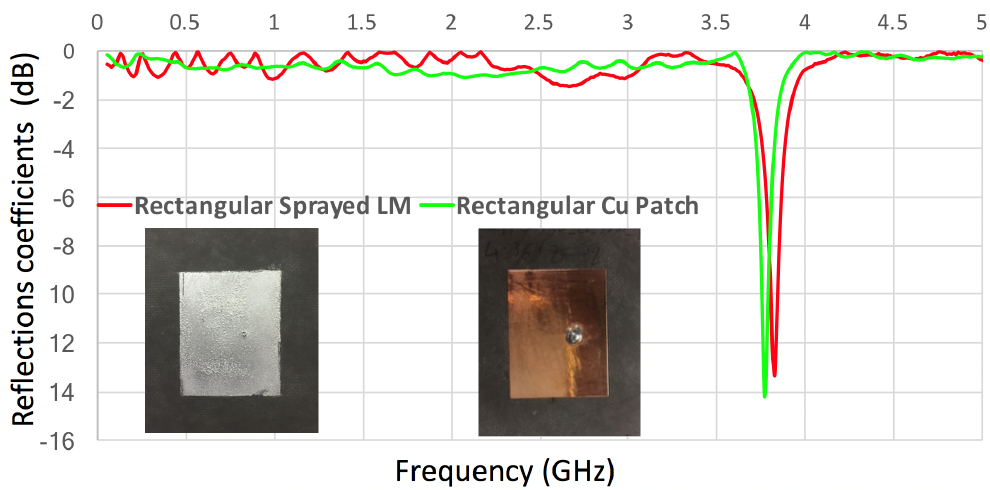
Figure 13. Reflection coefficient of Cu and LM rectangular patch antennas.